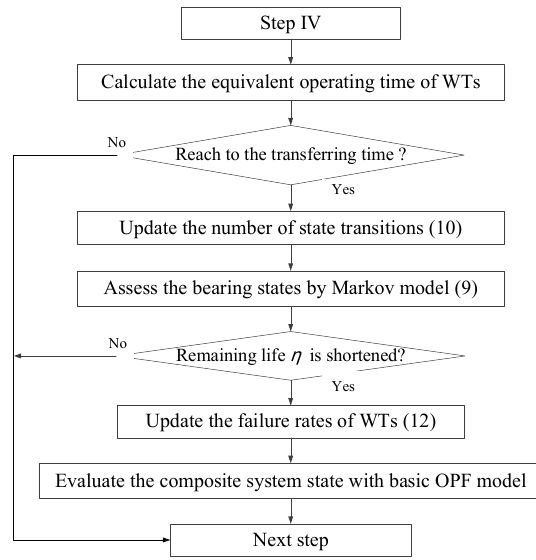
Figure 4. The flow of estimating the time-varying failure rates of wind turbines (WTs).